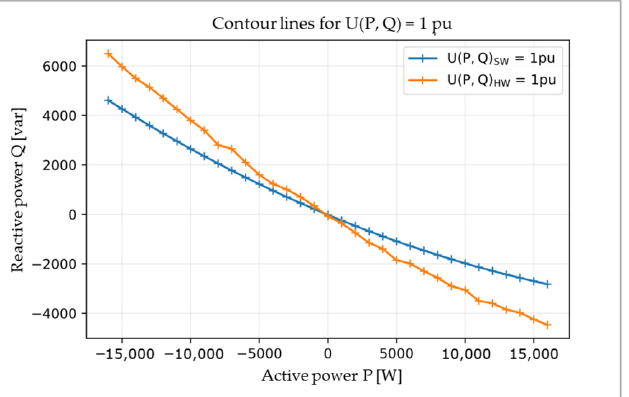
Figure 3. Contour lines representing tuples of reactive power (Q) and active power (P) leading to nominal voltage in software (SW, blue line) and hardware (HW, orange line).